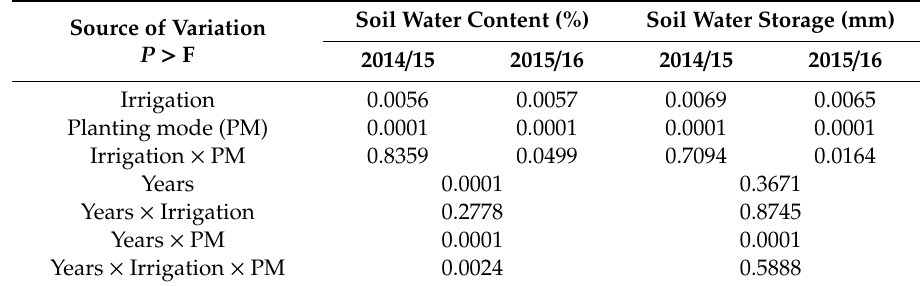
Figure 5. E ff ects of planting modes and irrigation on the soil water content during the growing season. W1, irrigation 50 mm water each at growth stage 34 (GS34) and GS48; W2, irrigation 100 mm water at GS48; and W3, irrigation 100 mm water each at GS34 and GS48; ns, not significantly di ff erent ( p > 0.05), triangle and circular symbols followed by the same letter are not significantly di ff erent according to the least significant di ff erence at 0.05. Table 4. Analysis of variance (ANOVA; p -values) for soil water content and soil water storage of winter wheat in the whole growing season.